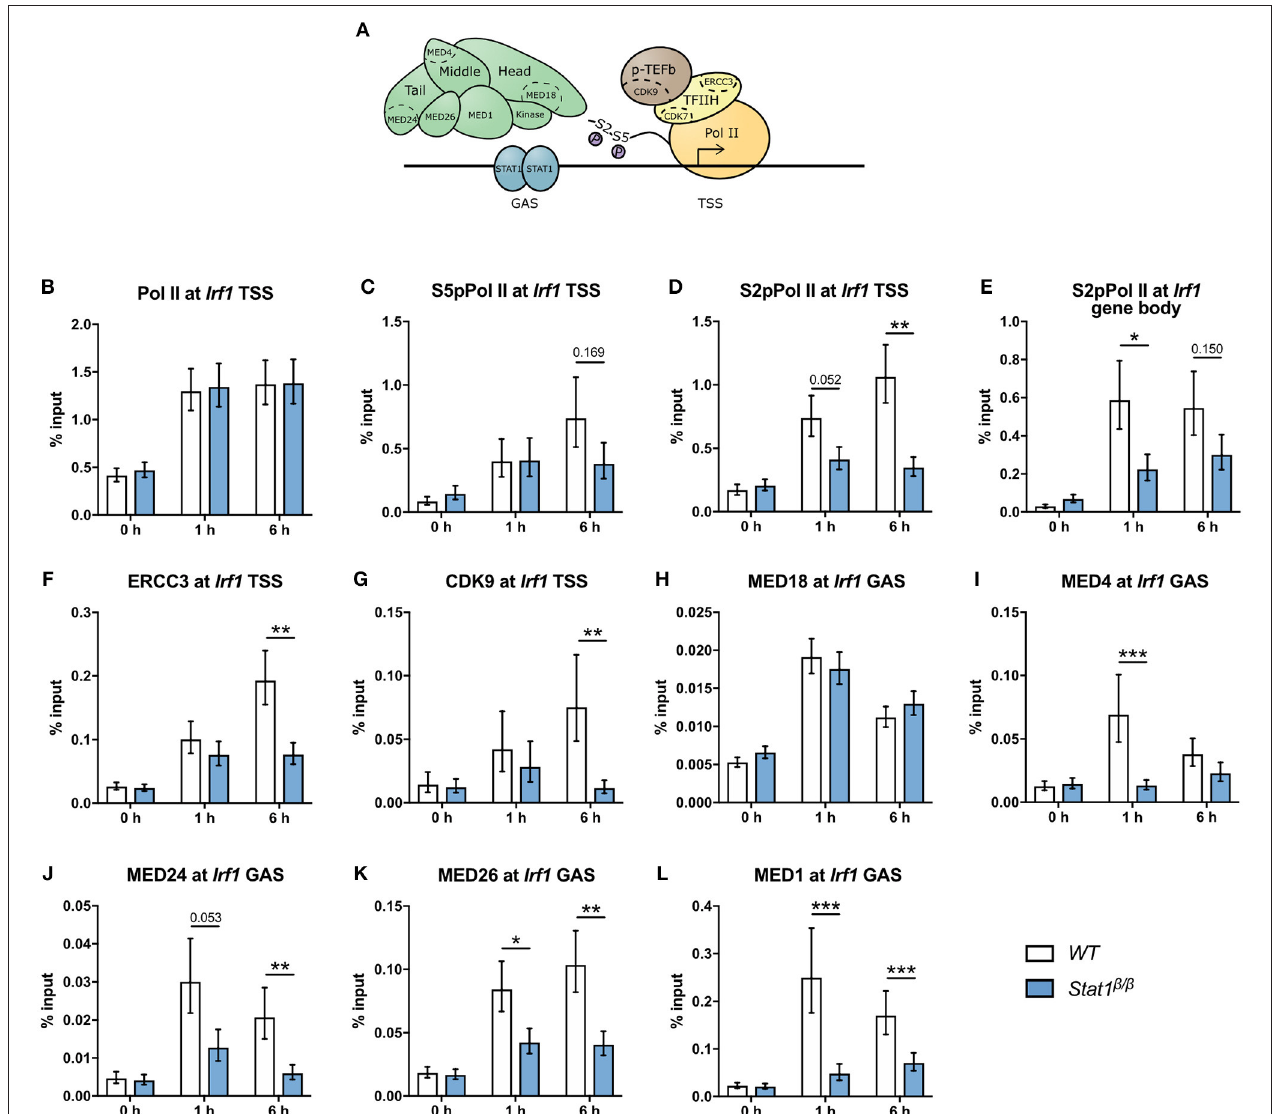
FIGURE 6 | Recruitment and phosphorylation of Pol II at Irf1 gene and occupancy of TFIIH, p-TEFb, and Mediator components at the Irf1 TSS. (A) Schematic representation of Pol II, GTFs, and the Mediator complex at a GAS-driven gene promoter. Components of the Mediator, TFIIH, and p-TEFb complexes analyzed by ChIP are indicated. (B–L) BMDMs from WT and Stat1 β/β mice were stimulated with IFN γ for the times indicated or left untreated (0h). Association of Pol II, S5pPol II, and S2pPol II with the Irf1 promoter around the TSS (B–D) and of S2pPol II within the Irf1 gene body (E) . Association of ERCC3 (F) and CDK9 (G) at the Irf1 TSS and of MED18 (H) , MED4 (I) , MED24 (J) , MED26 (K) , and MED1 (L) at the Irf1 GAS. Data were normalized to the input control. Mean values ± SE from two (H) or three (all others) independent experiments are shown; * P ≤ 0.05 , ** P ≤ 0.01 , *** P ≤ 0.001 .